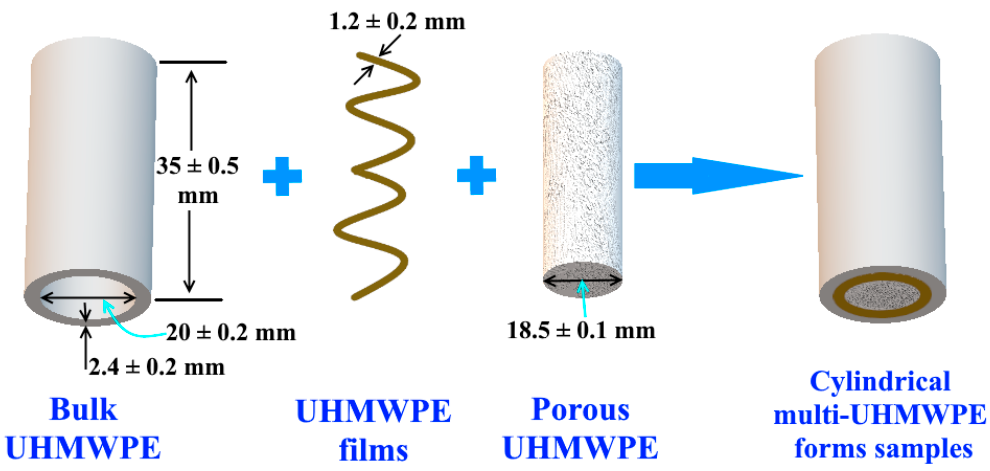
Figure 5. Cylindrical multi-UHMWPE forms samples, which consists of 3 UHMWPE forms. The armored layer consists of bulk and films of UHMWPE; and the trabecular layer consists of porous UHMWPE.